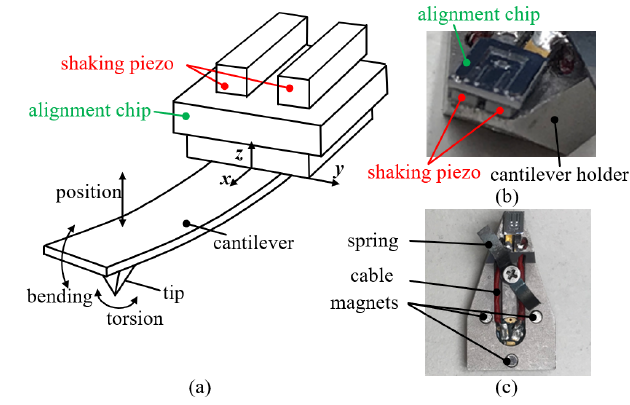
Figure 7. Schematic functional principle of the AFM probe (a) , the realized AFM probe (b) and the whole cantilever plug (c) .